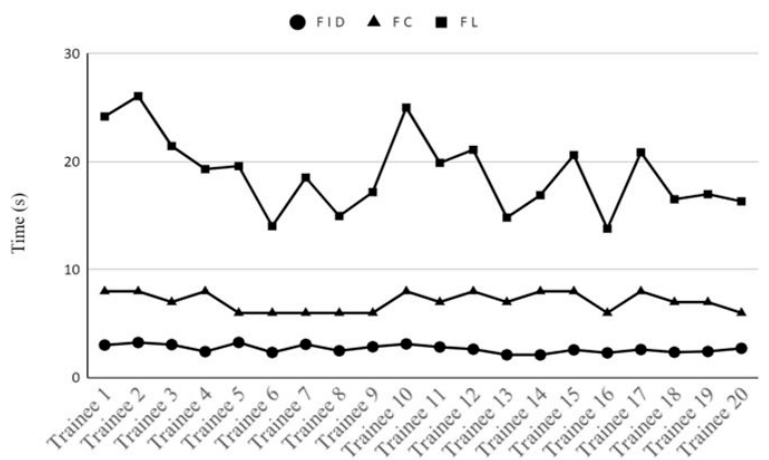
Figure 11. Fixation instance duration, fixation count and fixation length compared for all drivers.